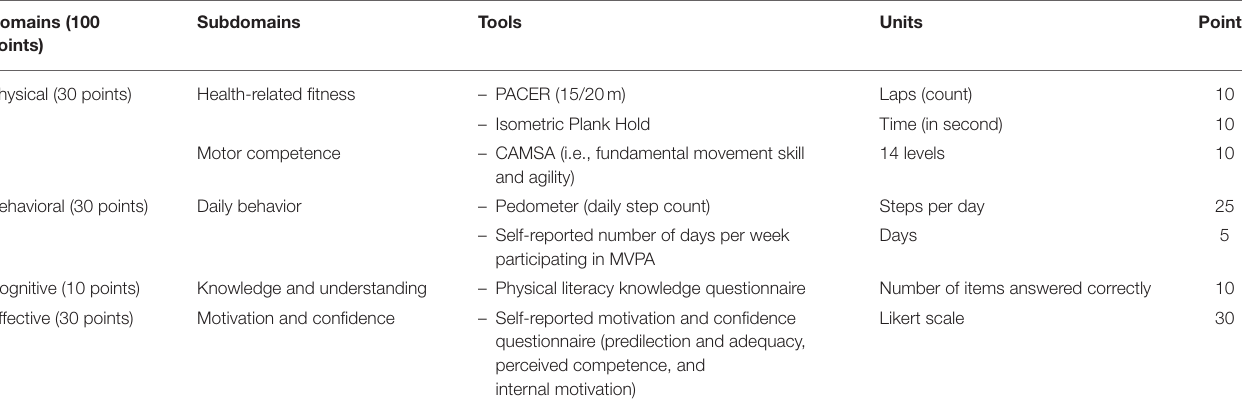
TABLE 3 | CAPL-2 overview: domain, tools, and scoring. Domains (100